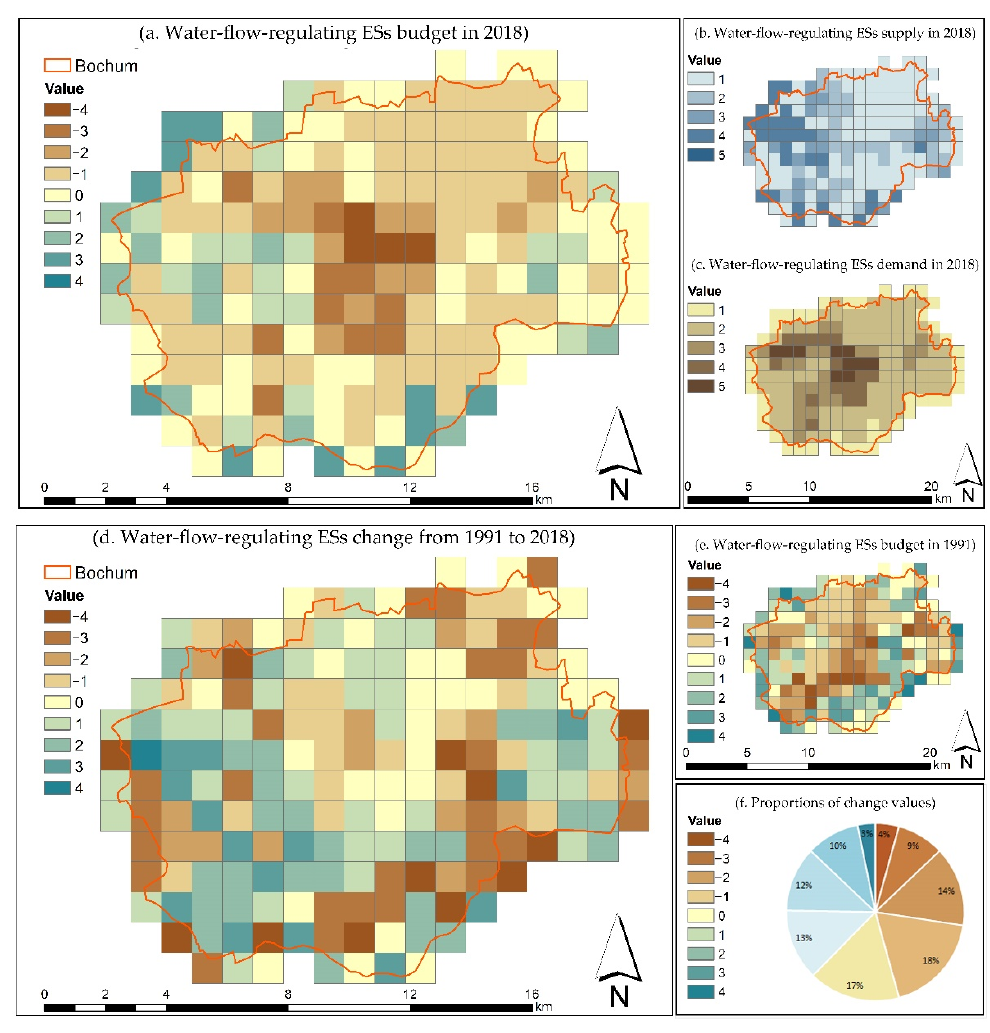
Figure 7. Water-flow-regulating ESs assessment results in 1991 and 2018. Figure 6. Water-flow-regulating ESs assessment results in 1991 and